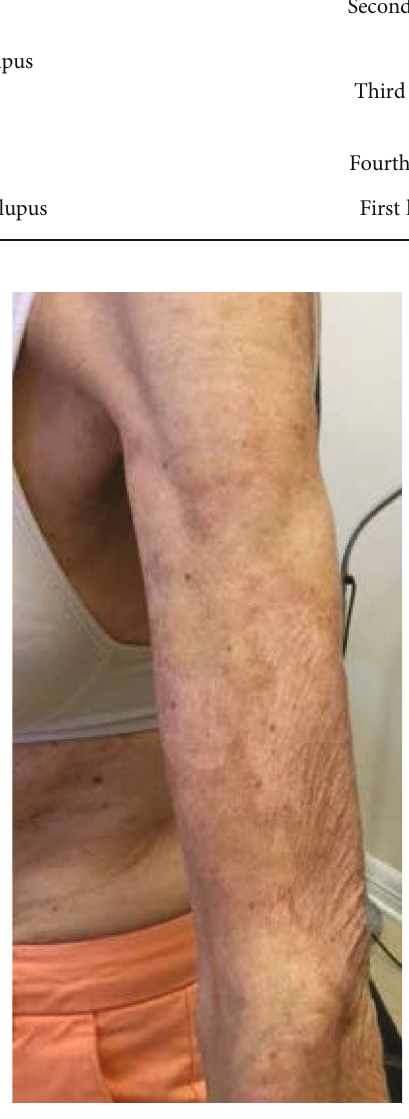
Figure 3: Subtle annular plaques on the left upper extremity of this female patient diagnosed with subacute cutaneous lupus